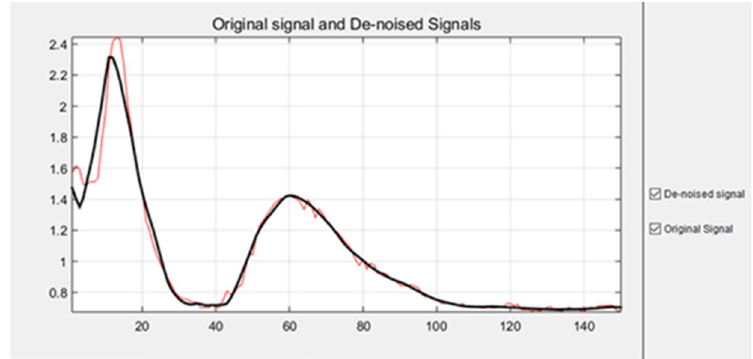
Figure 16. Comparison between a signal with noise, and a de-noised signal. In this case, the signal corresponds to a sample from the upward movement.